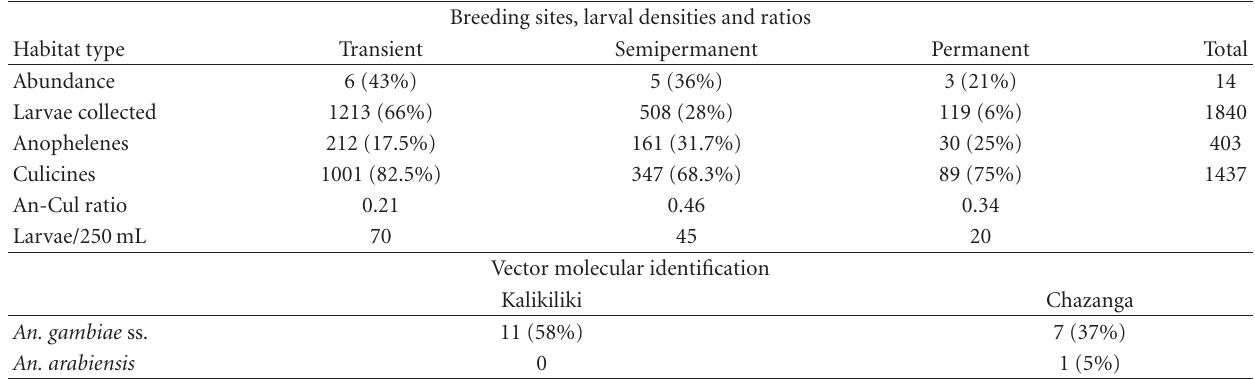
Table 1: Entomological survey